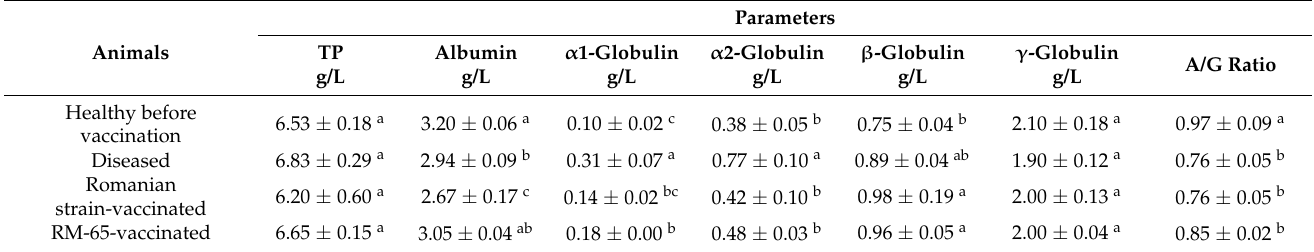
Table 2. Protein fractionation of the healthy, diseased, and vaccine A- and B-immunized animals.